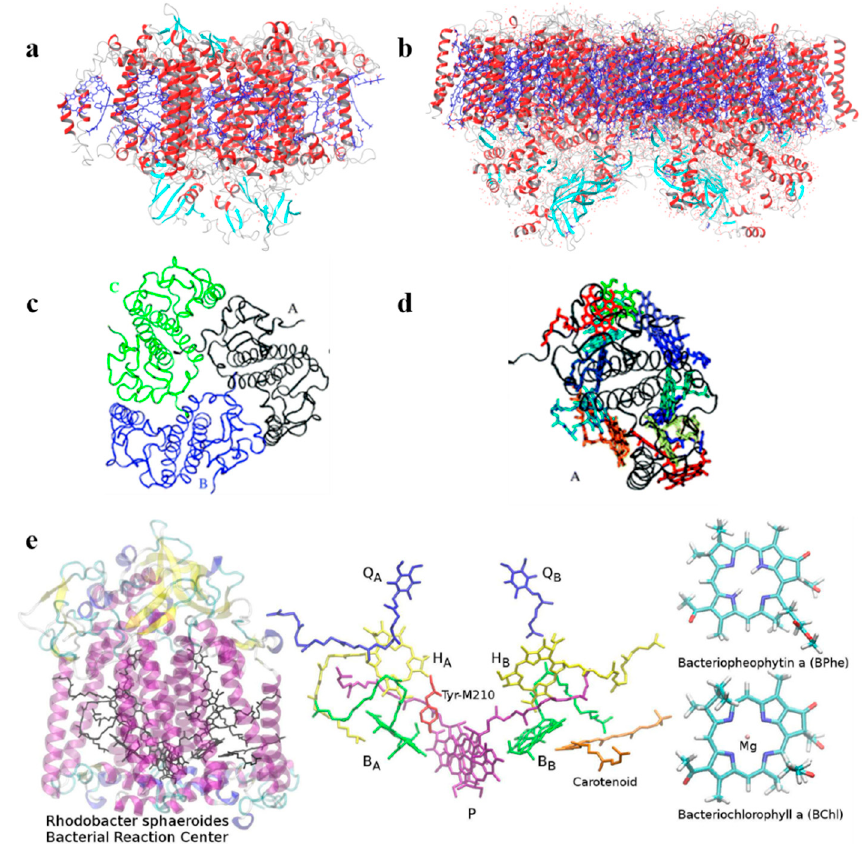
Figure 2. Structure of photosystem I (PSI, ( a )) and photosystem II (PSII, ( b )) from pdb entry 1JB0 and 3WU2, respectively. Trimeric light-harvesting complex (LHC II) complex from pdb entry 2BHW; the different chains are indicated by different colors ( c ); chlorophyll residues in chain A, in which the Chl residues are colored in yellow and red tones ( d ). Reproduced from [47] with permission from The Royal Society of Chemistry, 2011. Representation of the BRC of Rhodobacter sphaeroides based on X-ray study ( e ). The core pigment units are the P, and the pairs of BChl, and BPhe, shown in the central part along with representation of their neighbouring pigments that form the distinct effective dielectric for the two branches. Reprinted with permission from [50]. Copyright (2019) American Chemical Society.